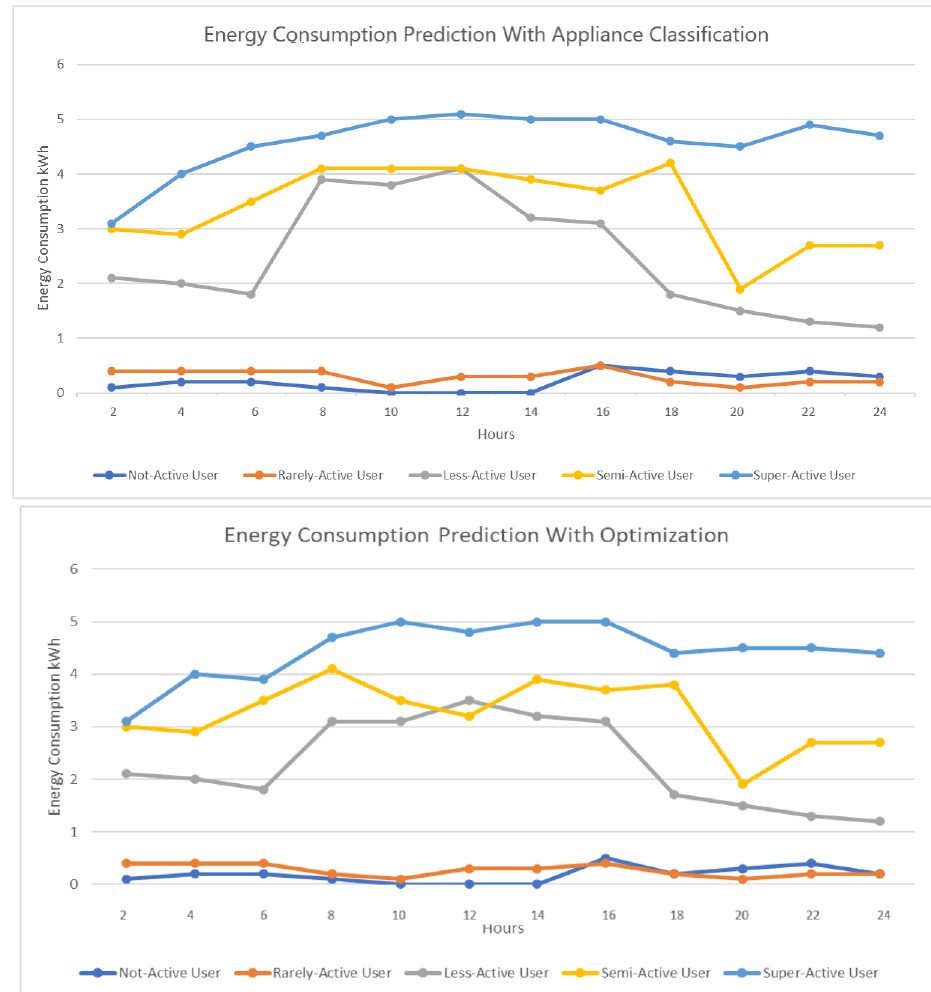
Figure 8. Energy consumption with optimization. Figure 9 represents the energy consumption when including scheduling. With a properly optimized scheduling algorithm, there is a sudden drop in the energy consumption for each user as can be seen in Figure